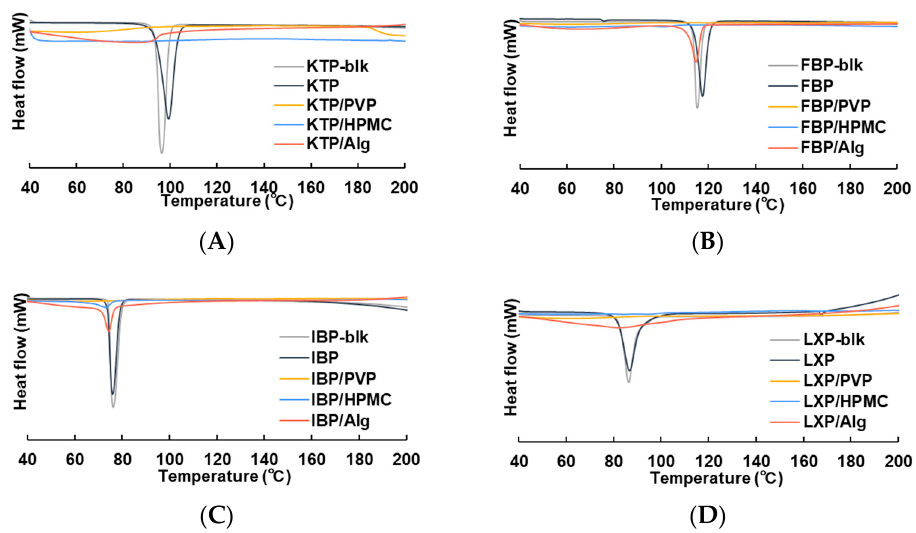
Figure 2. DSC thermograms of film formulations for ( A ) KTP, ( B ) FBP, ( C ) IBP, and ( D ) LXP. Ther- mograms are shown for API bulk (gray), control solid formulation derived from API alone (black), film formulation of API with PVP (yellow), film formulation of API with HPMC (blue), and film formulation of API with Alg